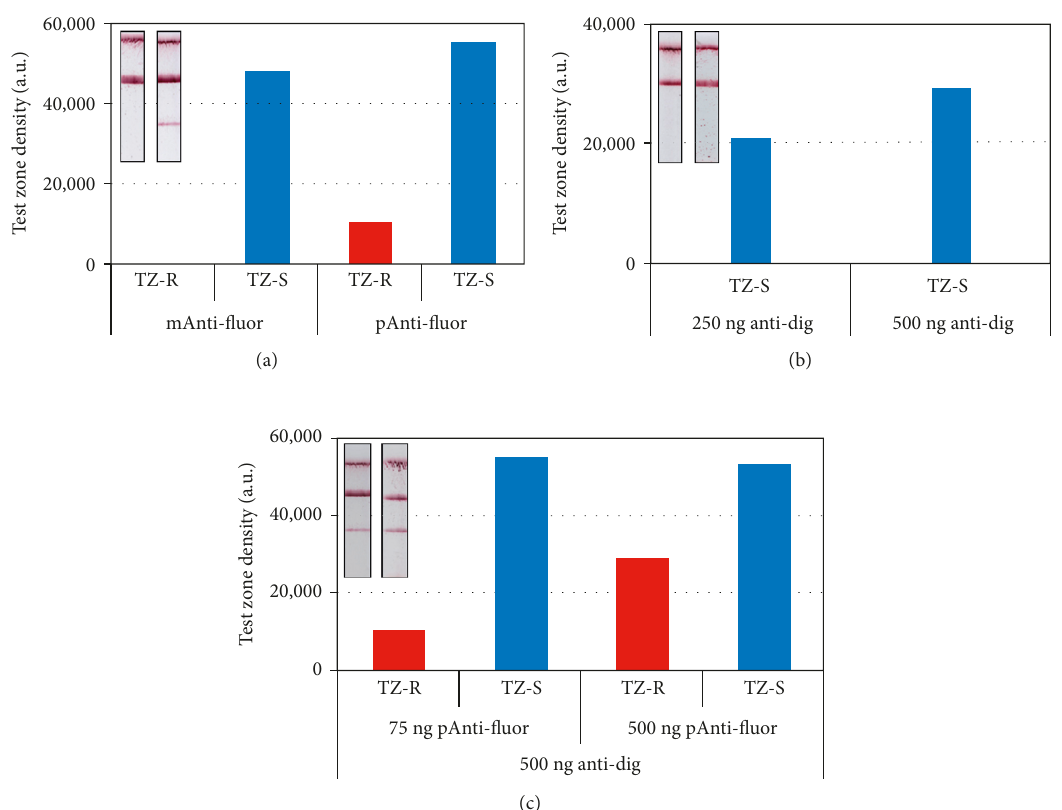
Figure 2: Dual lateral flow biosensor optimization studies. Representative lateral flow biosensors and signal intensity graphs for (a) effect of the use of monoclonal (mAnti-fluor) versus polyclonal (pAnti-fluor) anti-fluorescein antibody; (b) effect of the anti-digoxigenin (anti-dig) antibody amount for test zone construction; and (c) effect of the polyclonal anti-fluorescein antibody amount for test zone construction. All tests were performed with dig- and fluor-reference target mixtures. Signal is visualized with anti-biotin Au NPs. TZ-S: anti-digoxigenin zone; TZ-R: anti-fluorescein